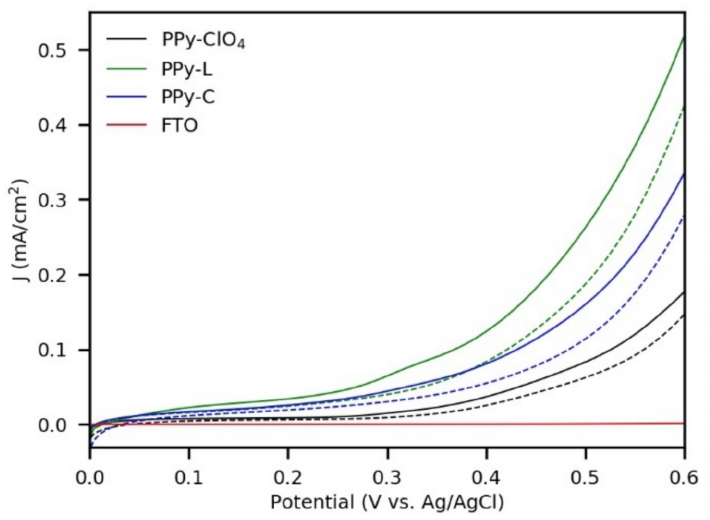
Figure 4. Linear sweep voltammetry (LSV) curves of bare FTO and PPy-films synthesized with 42 mC/cm 2 , under illumination (solid lines) and without illumination (dashed lines) in 0.1 M Na 2 S 2 O